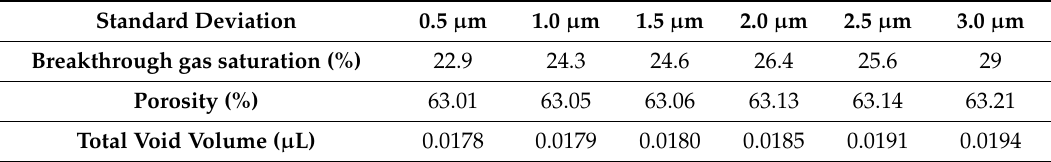
Figure 10 . Gas saturation at breakthrough of the gas phase for different PSDs. The mean value of throat sizes is 17 μ m. Table 3. Total void volumes and porosities associated with the gas saturation at breakthrough.